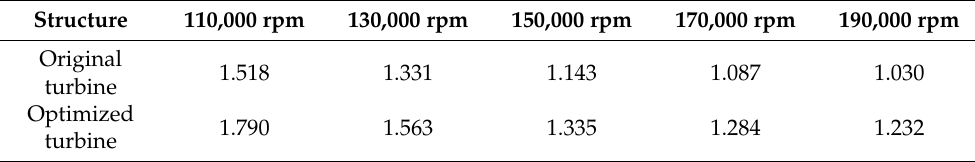
Table 8. Distribution of turbine pulse energy utilization